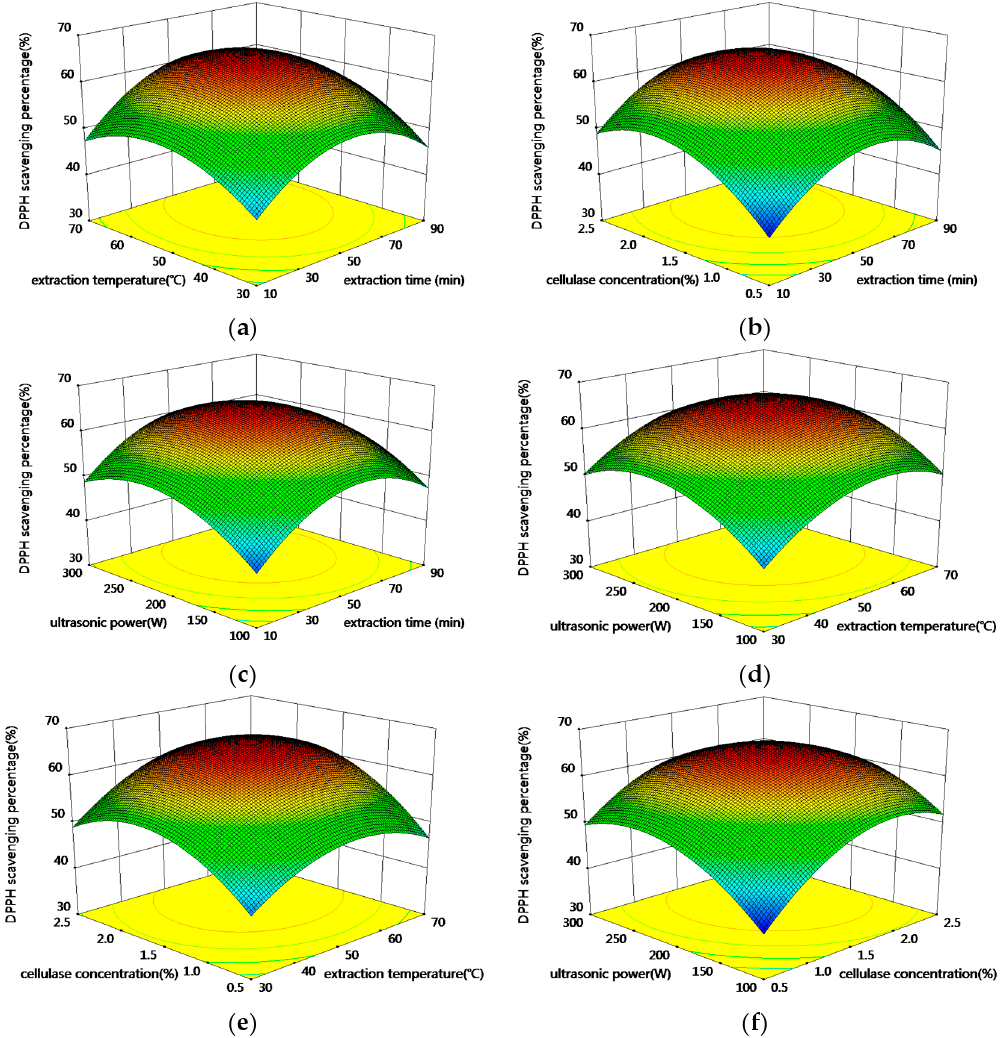
Figure 3. Response surface (3D) showing the effect of extraction parameters on DPPH scavenging percentage of RAMP. ( a ) extraction time and temperature; ( b ) extraction time and cellulase concentration; ( c ) extraction time and ultrasonic power; ( d ) extraction temperature and ultrasonic power; ( e ) extraction temperature and cellulase concentration; ( f ) cellulase concentration and ultrasonic power.